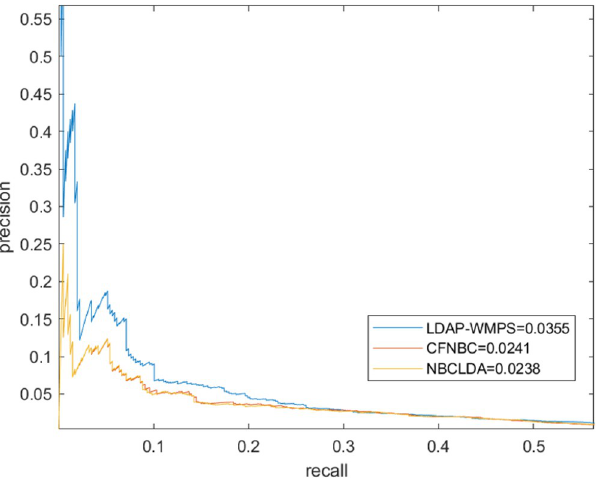
Fig 4. The performance of LDAP-WMPS and others models in terms of PR curves and AUPRs based on 407 known lncRNA-disease associations under the framework of LOOCV.